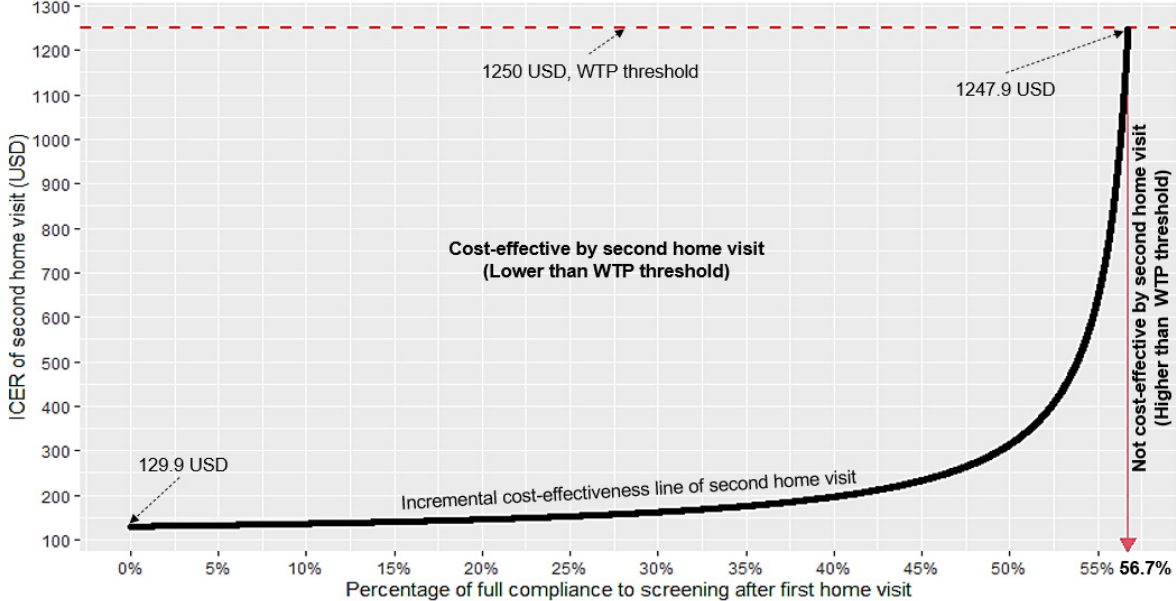
Figure 2. Graph showing ICER value changes with different percentages of full compliance from the first home visit. ICER: incremental cost-effectiveness ratio; WTP: willingness to pay.